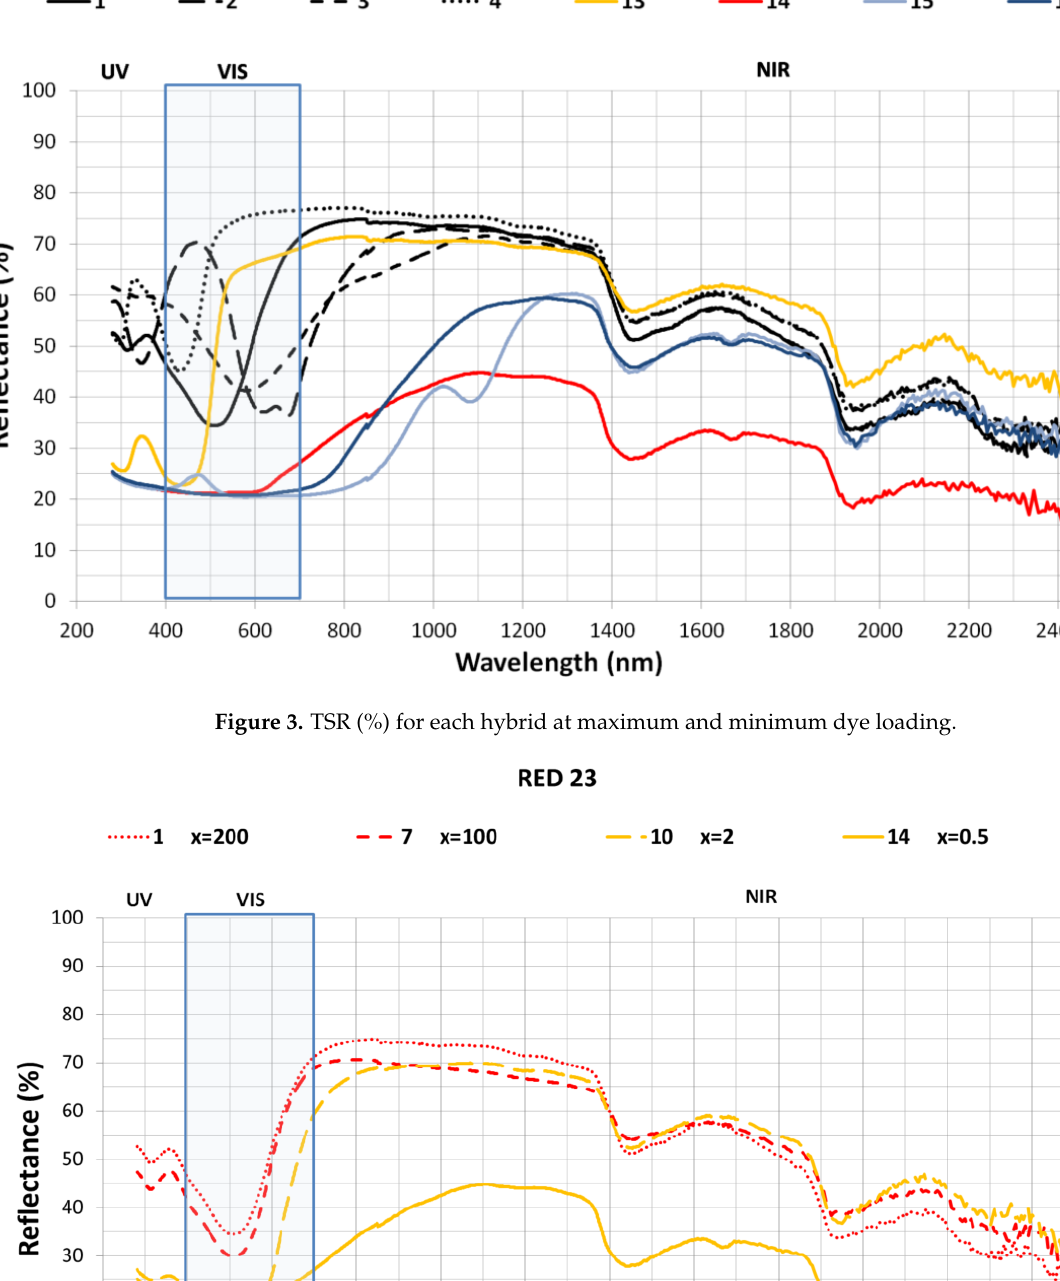
values affecting the future applications that should be considered.